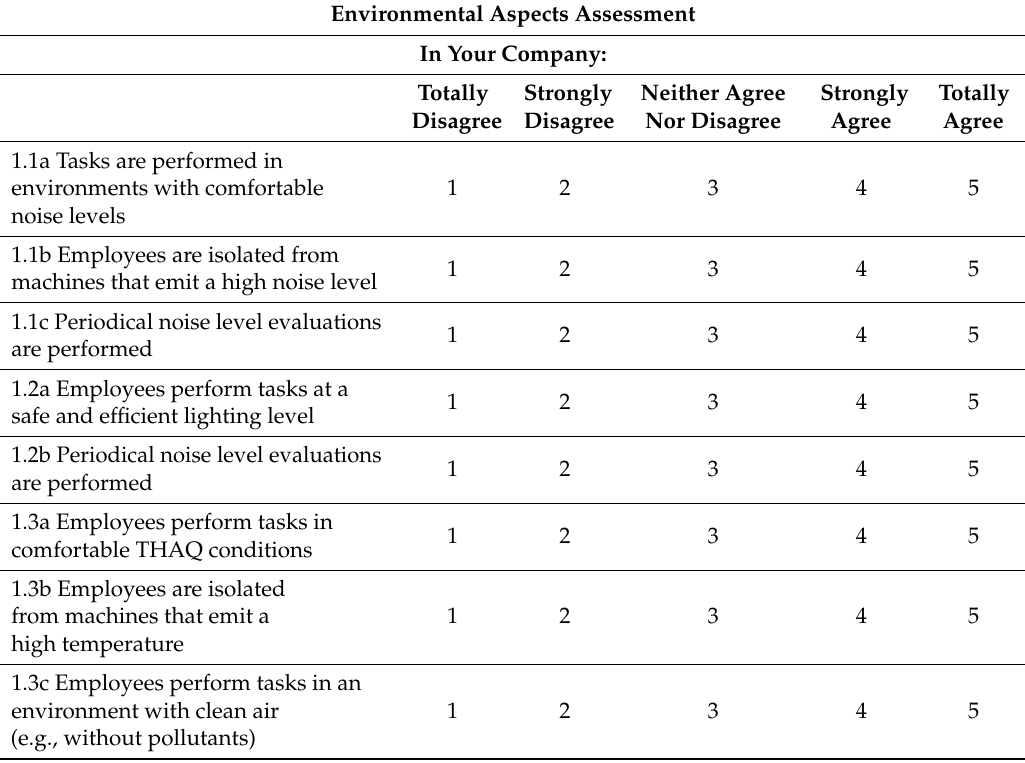
Table 3. Environmental aspects considered in the MCQ.